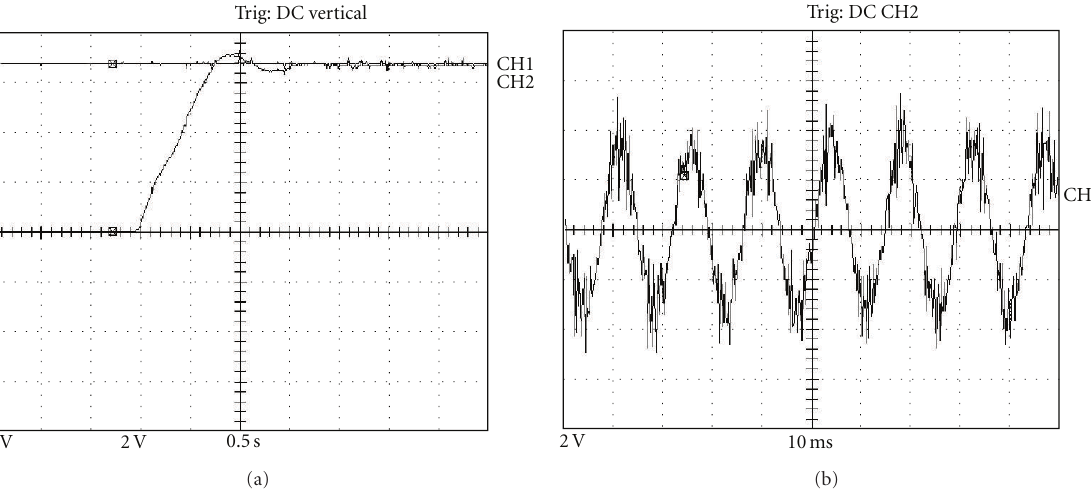
Figure 10: (a) Experimental speed of IPMSM drive for flux-weakening control with reference speed 220 rad/sec using PI controller ( Y - axis: 1 div = 65rad/sec). (b) Experimental steady-state current response of IPMSM drive for flux-weakening control with reference speed 220rad/sec using PI controller ( Y -axis: 1div = 2